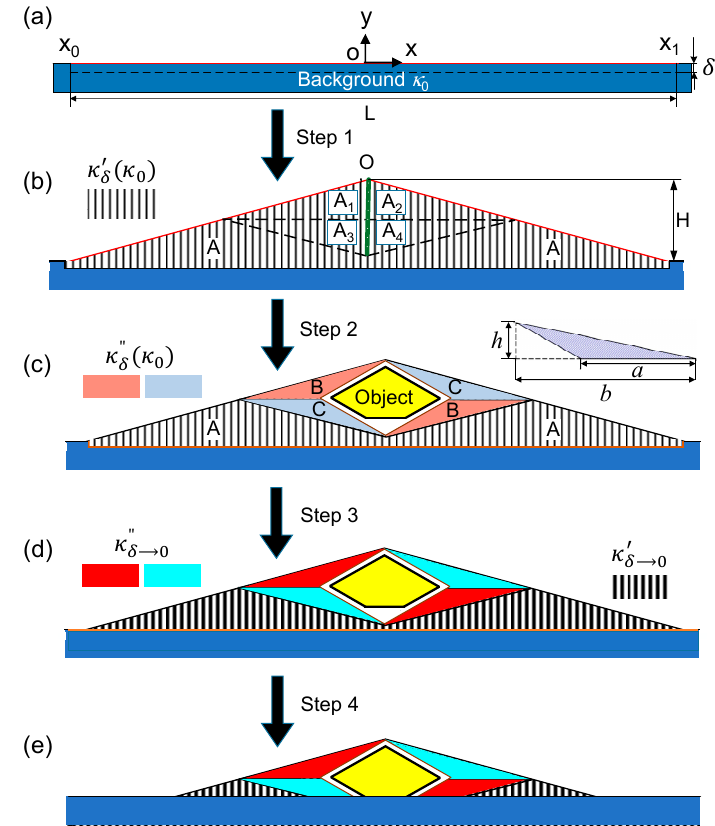
Figure 10. Flow diagram of designing the radiative thermal cloak [17]. ( a ) The background; ( b ) Step 1: space creation; ( c ) Step 2: perform the transformation of a unidirectional thermal cloak; ( d ) Step 3. space elimination; ( e ) Step 4: final design.